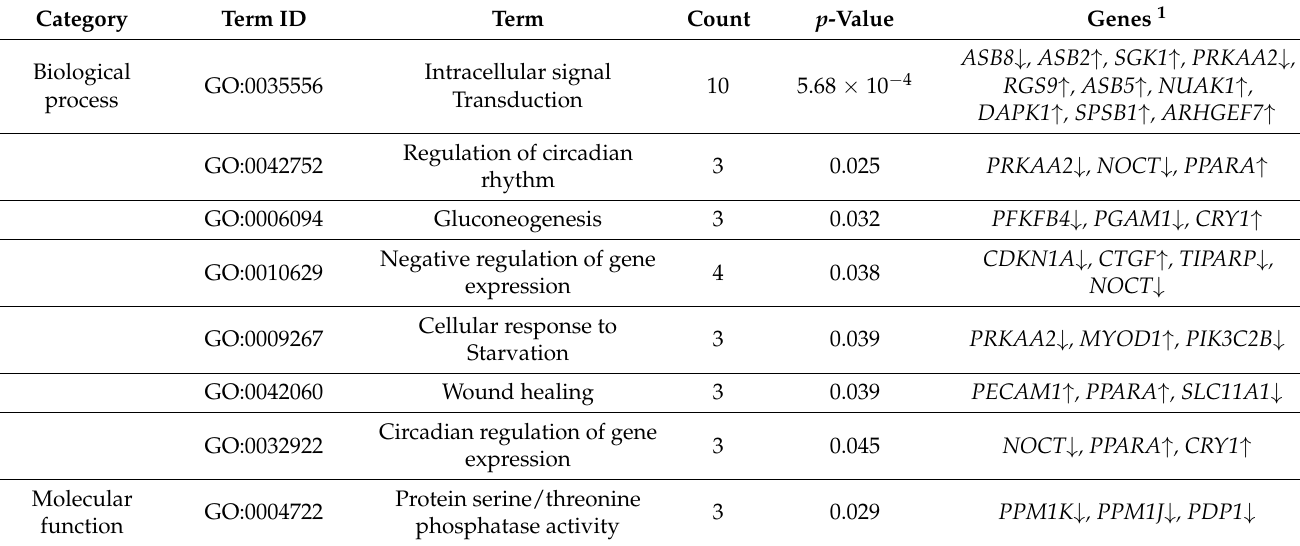
Table 3. Significantly enriched gene ontology terms in the L-histidine supplementation group compared to the non- supplemented group.